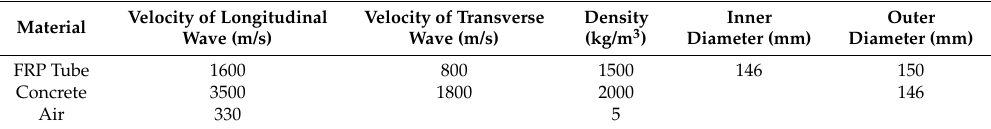
Figure 1. Geometry of the numerical model of the concrete-filled fiber-reinforced polymer tube (CFFT). Table 1. Material properties for the numerical simulation.